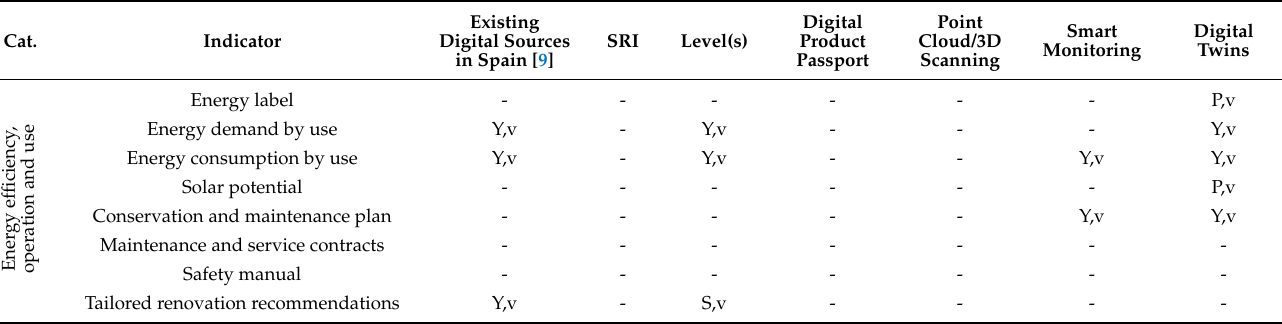
Table A4. Category 4: Energy efficiency, operation and use.